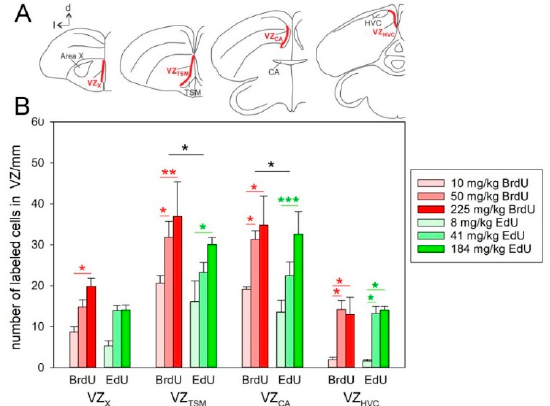
Figure 3. The schematic drawings of the brain ( A ) and the number of cells labeled by di ff erent doses of BrdU or EdU in di ff erent parts of VZ ( B ). ( A ) The schematic drawings show one hemisphere in coronal sections with the locations of parts of ventricular zone (VZ) that were used for quantification (highlighted red). Area X and HVC—vocal nuclei, CA— commisura anterior ; TSM— tractus septopallio-mesencephalicus. ( B ) Graph showing quantification of BrdU (red bars) and EdU (green bars). Each bar represents mean and SEM. The highest numbers of labeled cells were found in VZ TSM and VZ CA and there was a di ff erence between the numbers of BrdU + and EdU + cells in these two regions. Red stars are for the comparisons within BrdU, green stars are for the comparisons within EdU, black stars are for the comparisons between BrdU and EdU. * is p < 0.05, ** is p < 0.01, *** is p < 0.001. ANOVA and Fisher’s LSD test. BrdU was detected by the antibody